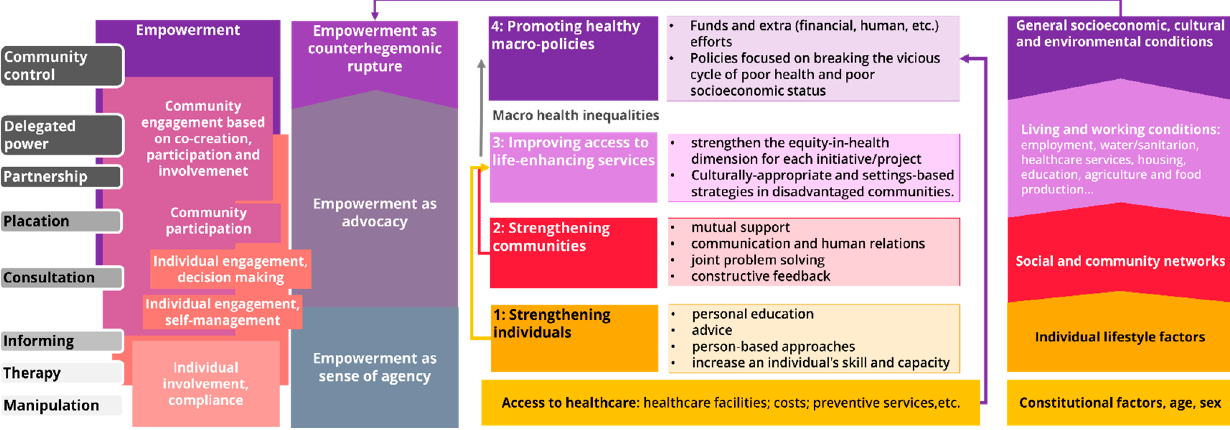
Figure A1. Scheme reflecting the relation between the ladders of participation, the typology of the intervention and the social determinants of health in light of the communities’ engagement and empowerment. Prepared by the authors based on [16,42,43].